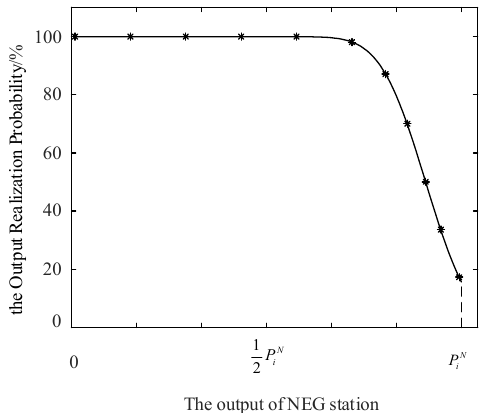
Figure 4. The output realization probability of the REG station i at moment t . According to the output realization probability of each REG station, the section mar ‐ gin is reasonably allocated to each REG station, which can ensure that each REG station has the highest probability of meeting the output power command and improve the reli ‐ ability of the section power